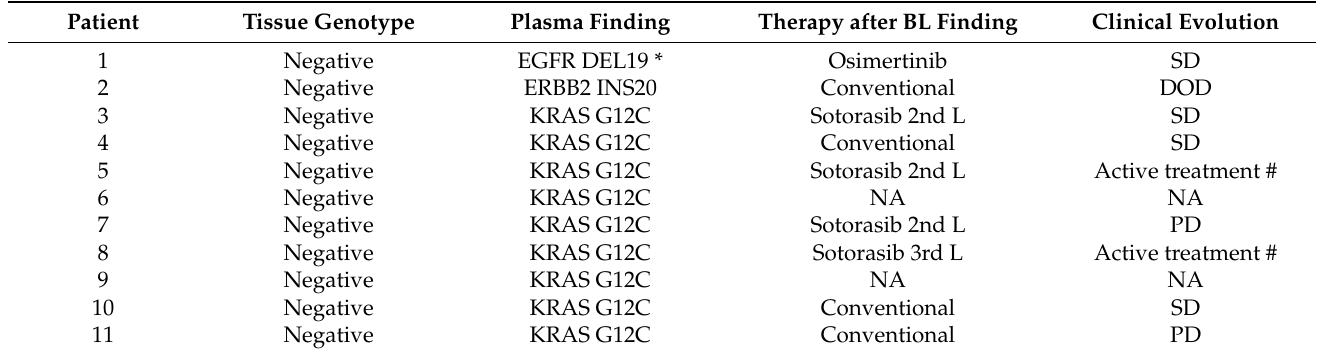
Figure 1. Summary of liquid biopsy (LB) results in the cohort with breakdown of molecular findings and comparison of the biomarker outcome with matched tissue evaluation by single-gene testing (SGT). NGS: next-generation sequencing with a 17 genes panel covering all guideline-recommended biomarkers. Table 3. Cases with potentially targetable driver alterations identified by liquid biopsy